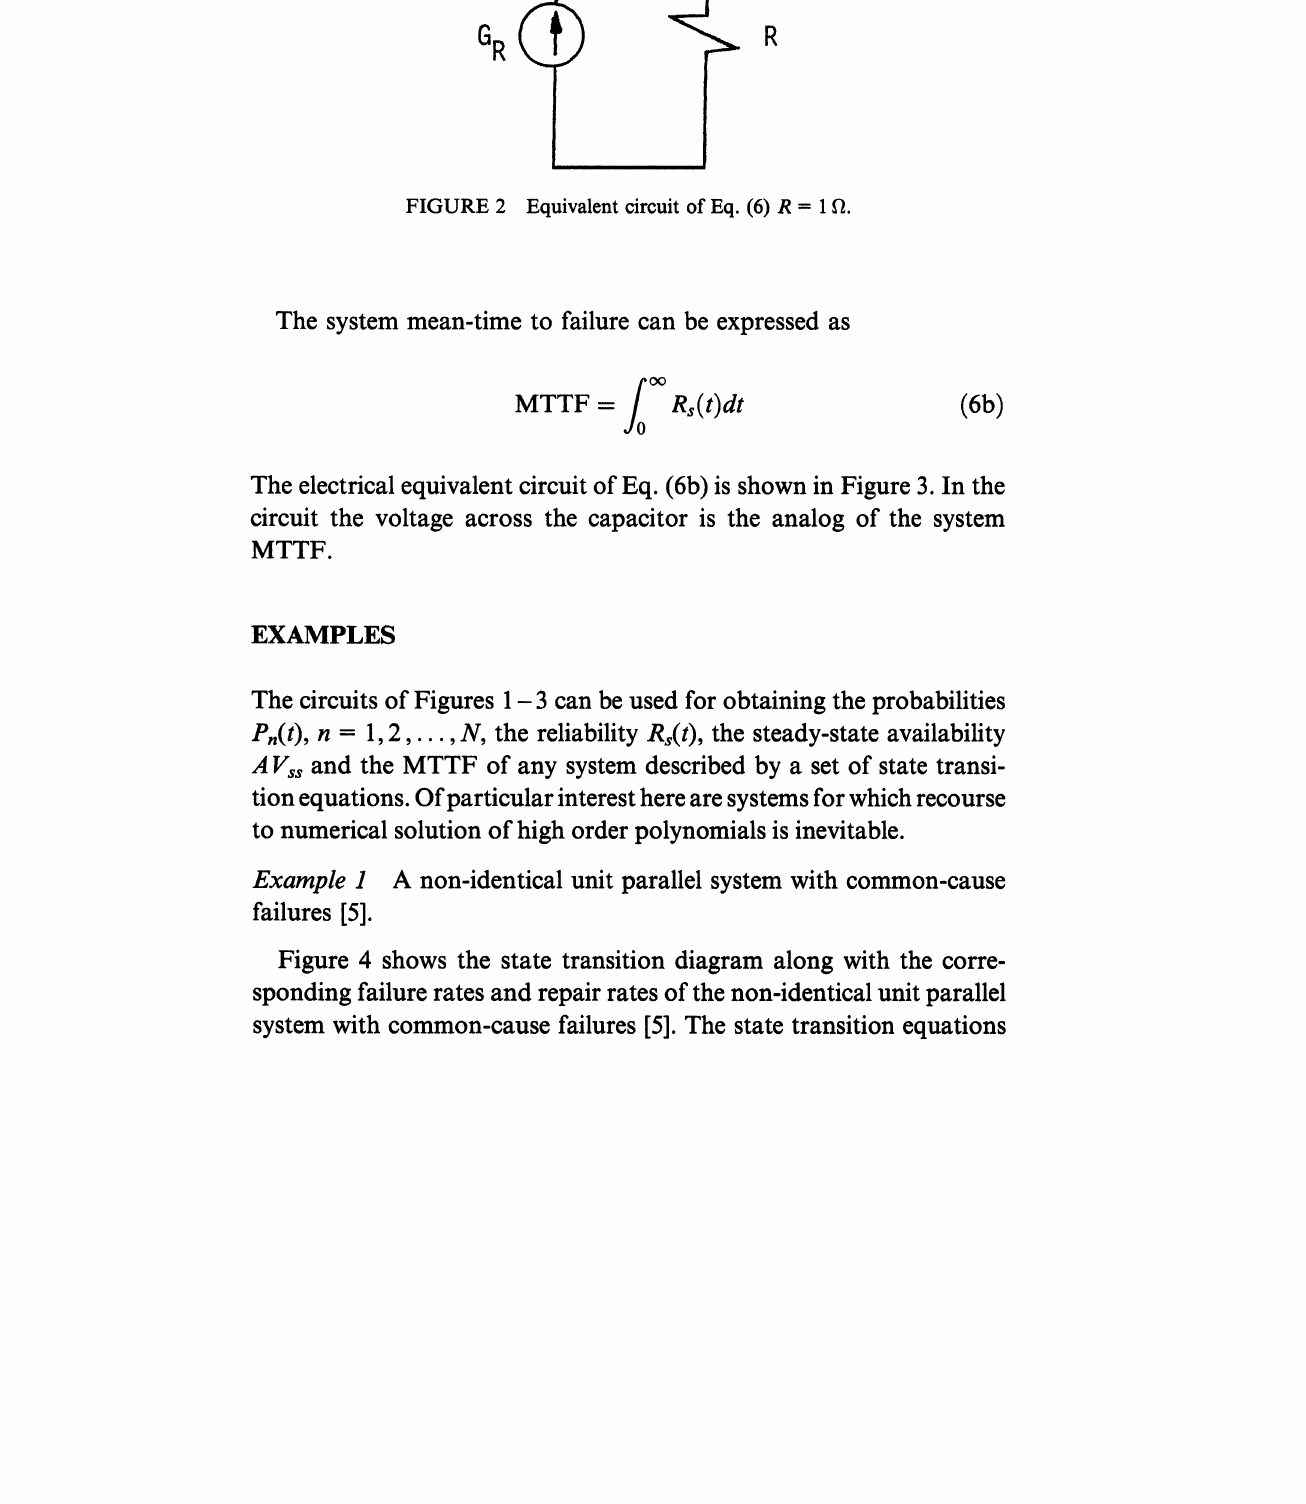
FIGURE 2 Equivalent circuit of Eq. (6) R